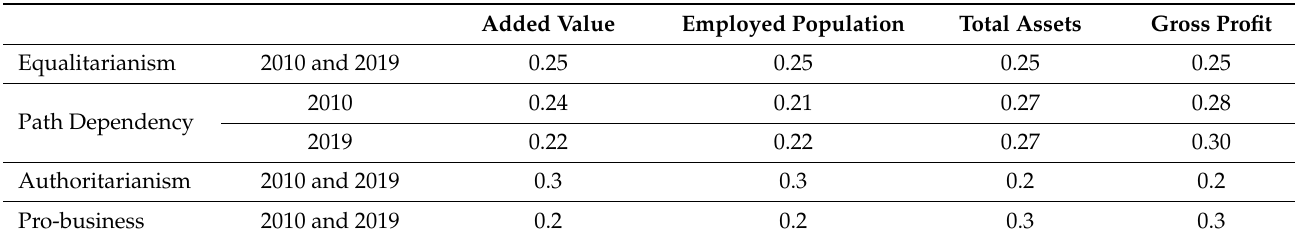
Table 8. Weighting schemes based on different value orientations in the YRD.